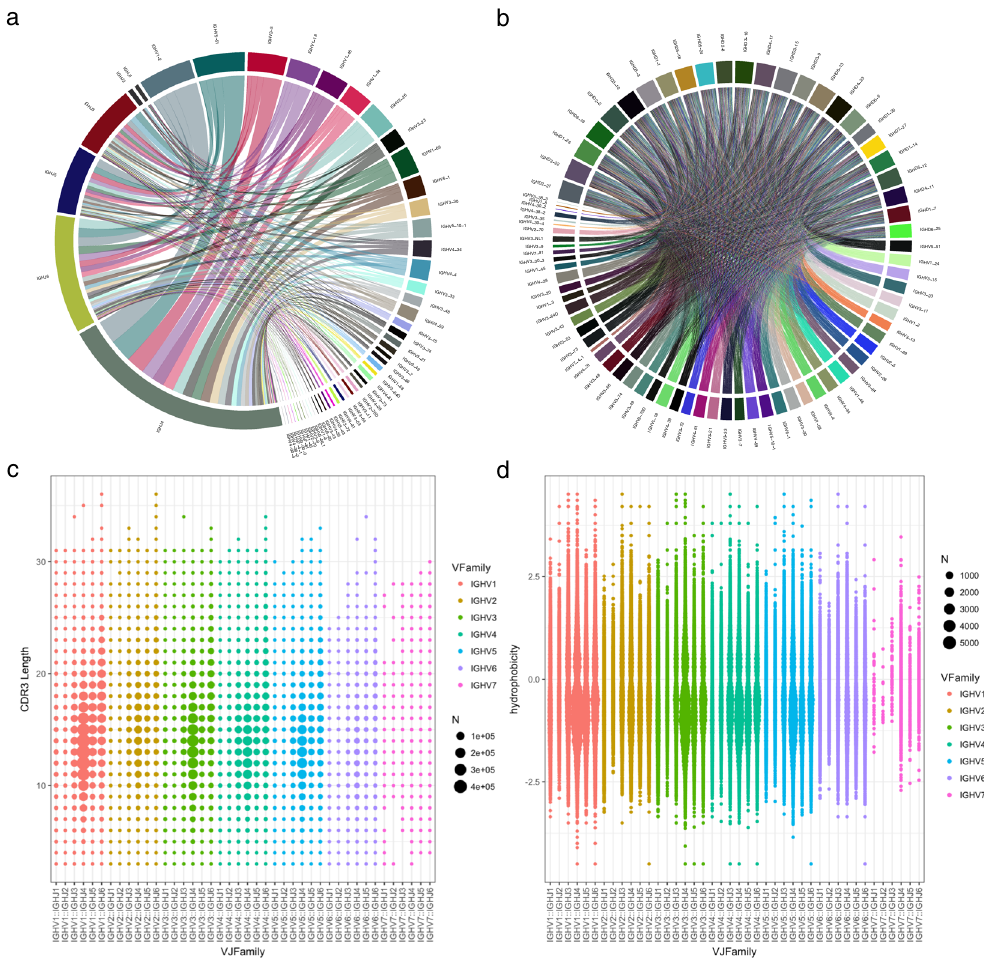
Fig. 5 Biophysical characteristics in the fi nal library show a broad distribution of binding features. a Circos graph of V/J coupling in the heavy chain. b Circos graph of V/J coupling within combined IGKV/IGLV library. c HCDR3 length distribution for different IGHV:IGHJ combinations. d Calculation of hydrophobicity index using GRAVY for different IGHV:IGHJ